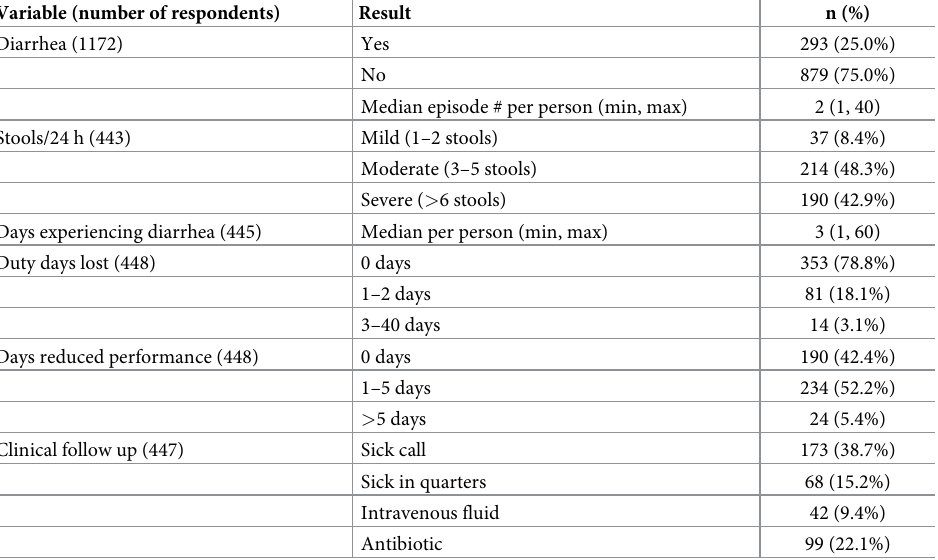
Table 2. Post deployment questionnaire, impact of diarrhea.